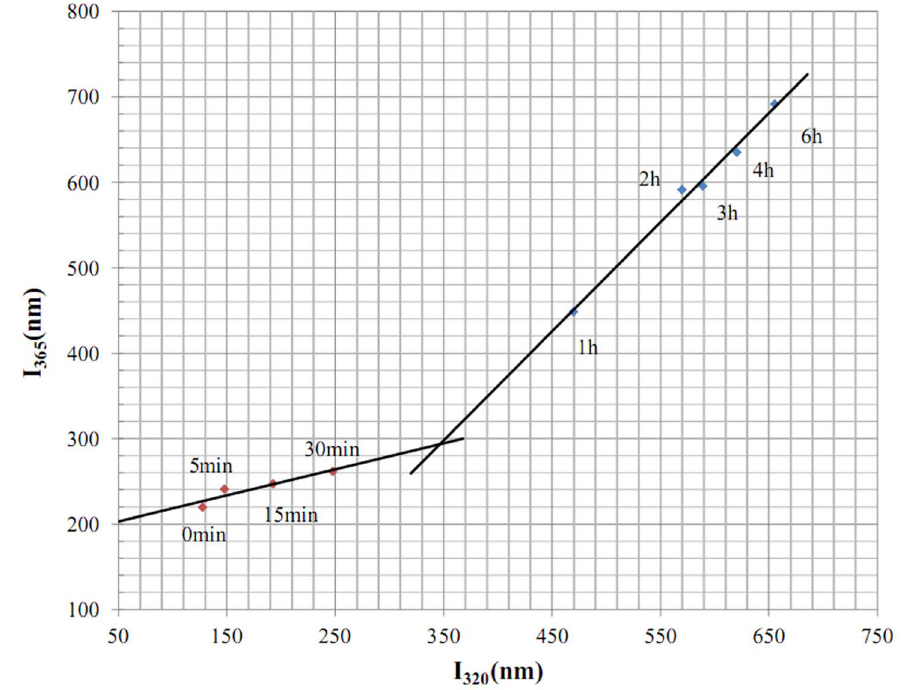
Figure 3. Phase diagram of the aggregates according to incubation time.